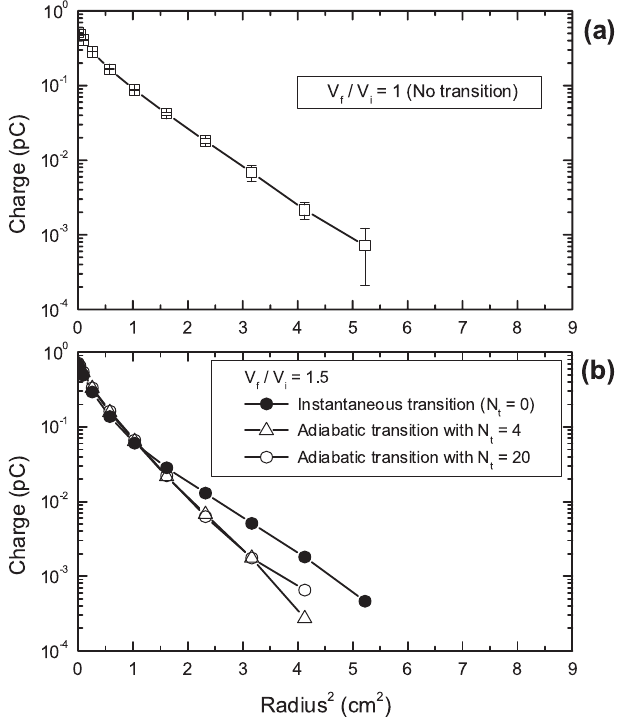
FIG. 3. Measured radial beam profiles (a) prior to transitions and (b) after transitions with V made instantaneously (solid circles), adiabatically with N (open triangles), and adiabatically with N The initial smooth-focusing vacuum phase advance (cid:5) sf and the applied focusing frequency f is fixed at 60 kHz during the transitions. A straight line in the log versus r 2 plot indicates that the radial profile is a Gaussian function of r .